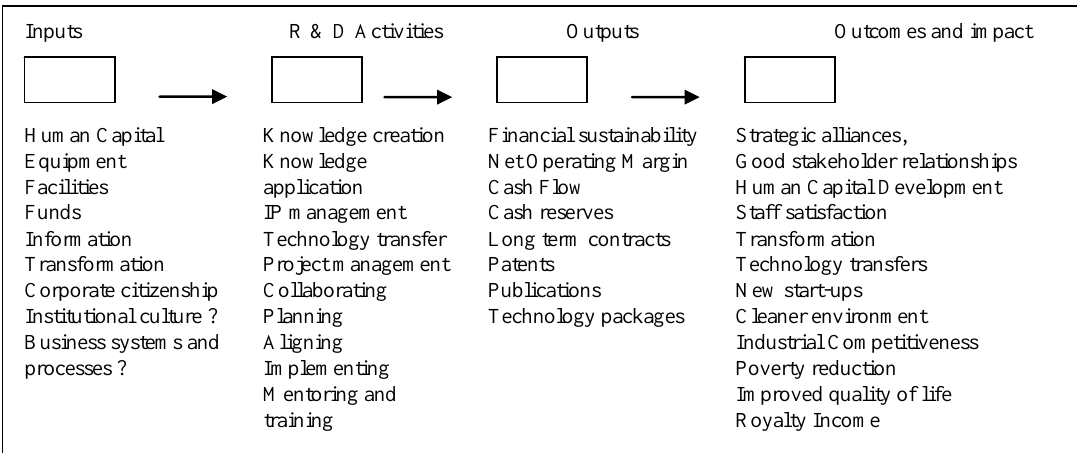
Figure 2: The MSM value